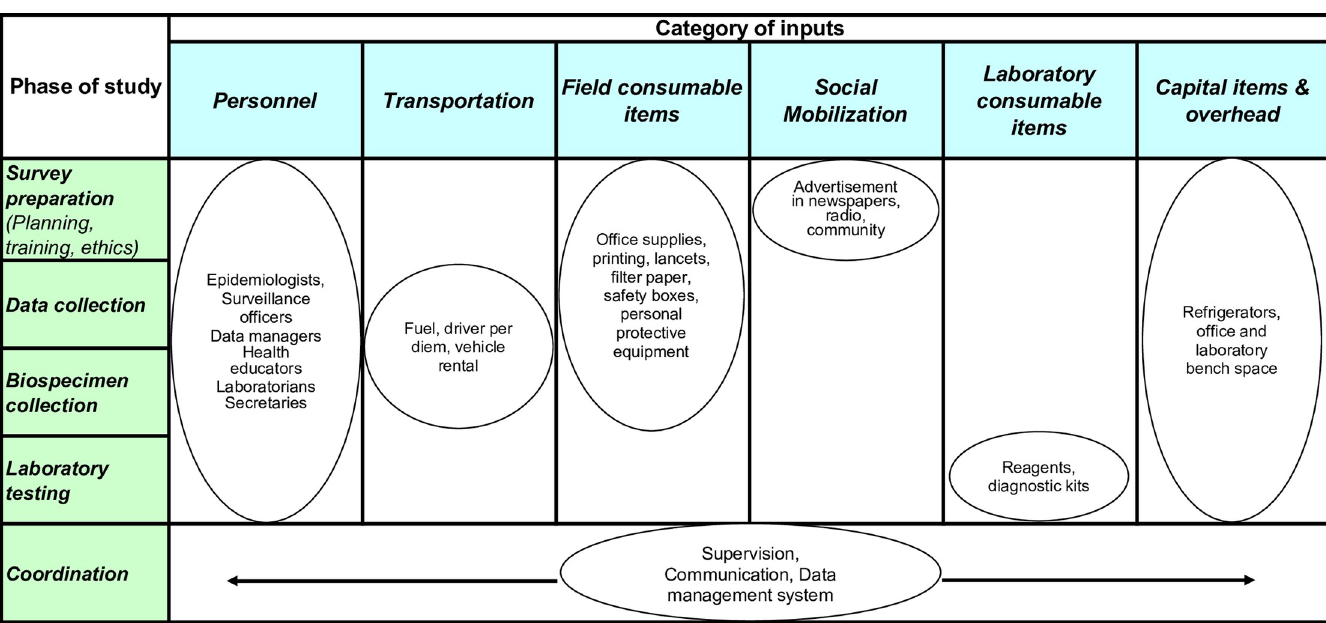
Fig 1. Framework for estimating serosurvey costs. The framework was adapted from integrated disease surveillance and updated to capture serosurvey costs. Phase of study includes cores study activities. Columns represent input categories. Overlap across the matrix is captured in the costs.